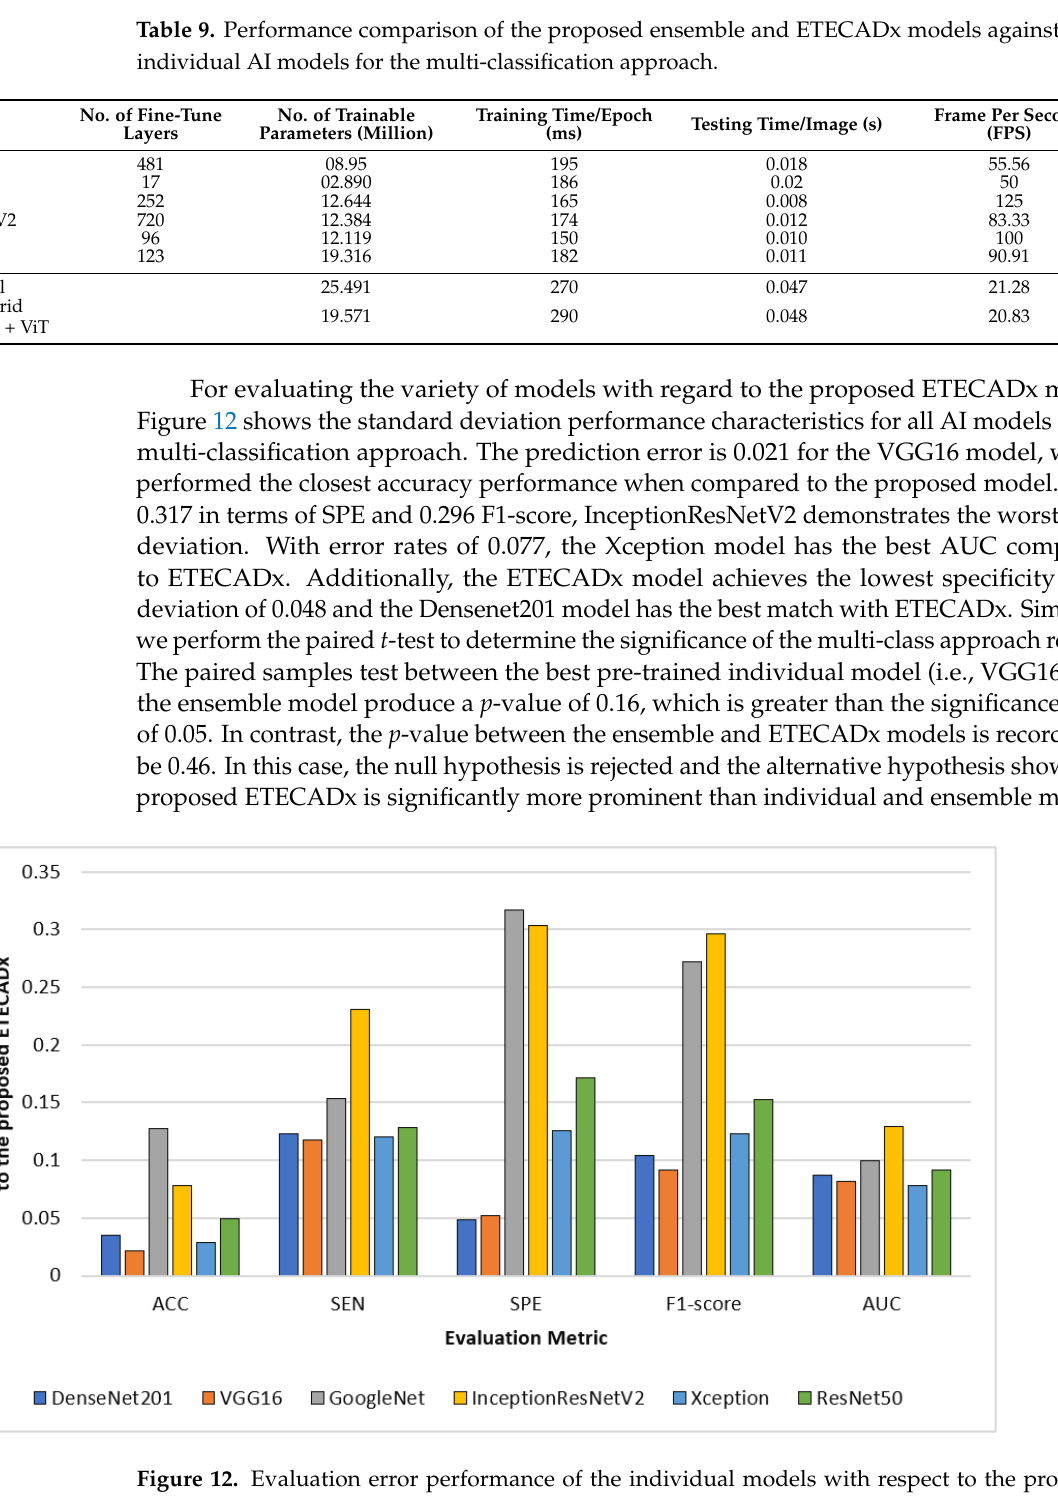
Figure 12. Evaluation error performance of the individual models with respect to the proposed ETECADx model in the multi-class approach.